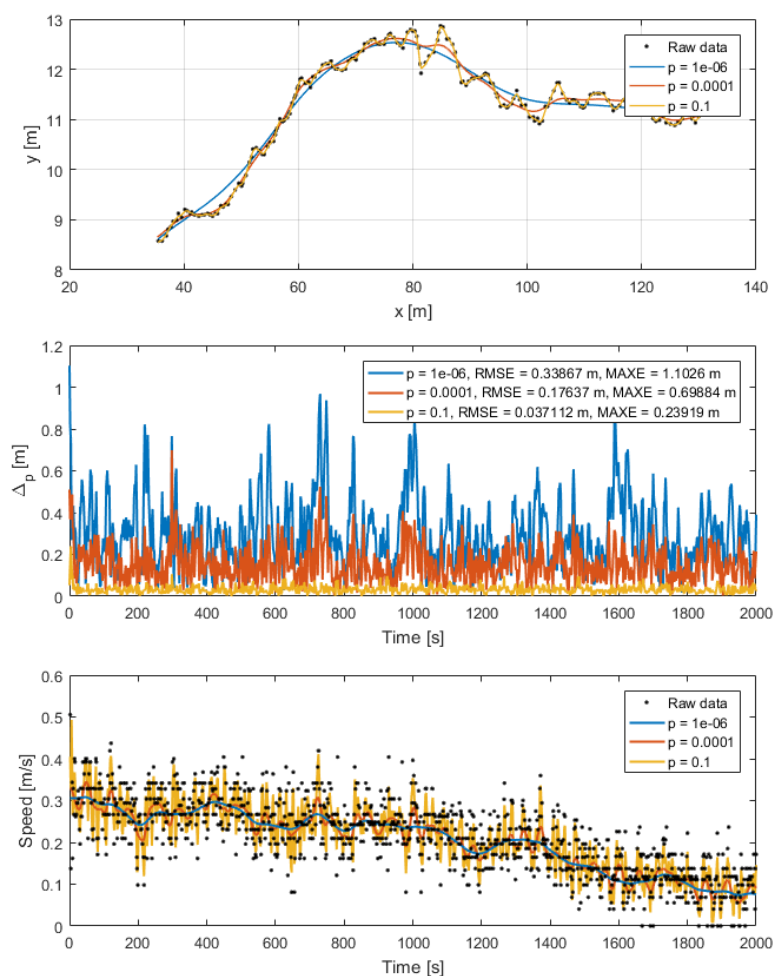
Figure 9. Smoothing spline for different parameters p : smoothed trajectory with highest deviation vs. input data ( top ); deviations in the position of the point depending on parameter p (with the root mean square error (RMSE) and the absolute error displayed in the legend) ( middle ); and the derived speed from the raw data vs. the derived speed from the filtered data ( bottom